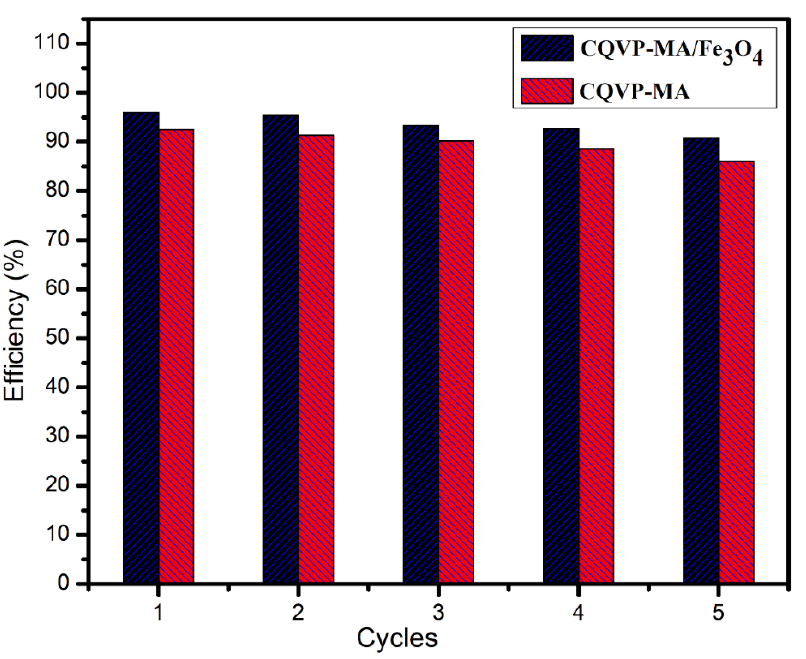
Figure 13. Reusability of CQVP/MA and CQVP/MA-Fe 3 O 4 for CBB dye adsorption from aqueous solution.